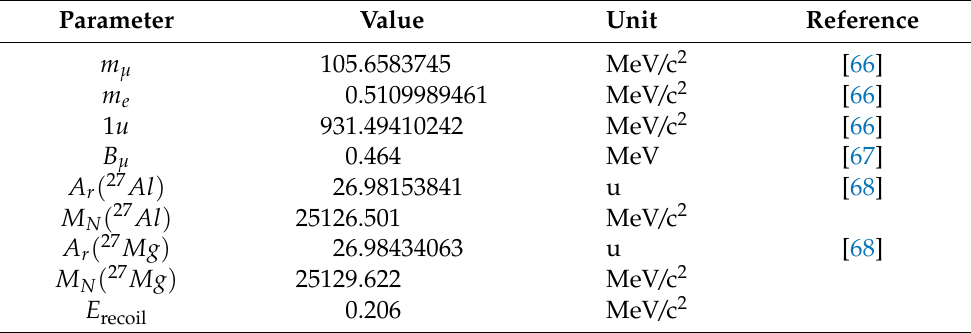
Table A1. Parameters used in the RMC endpoint energy calculation on